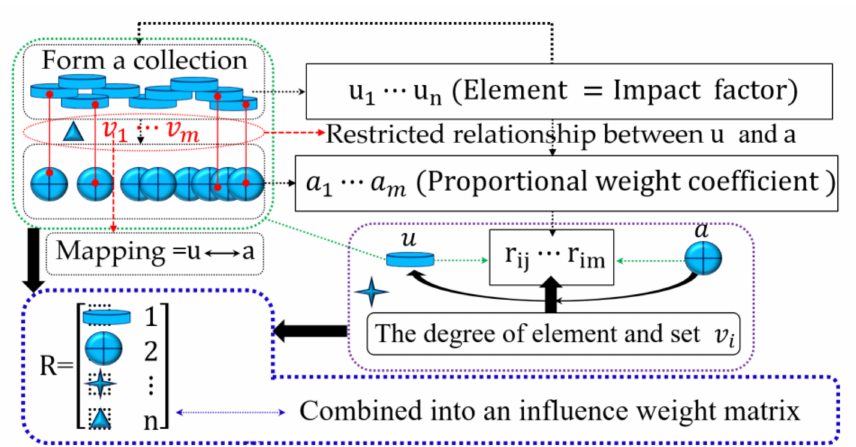
Figure 4. Schematic diagram illustrating the single factor influence weight matrix.